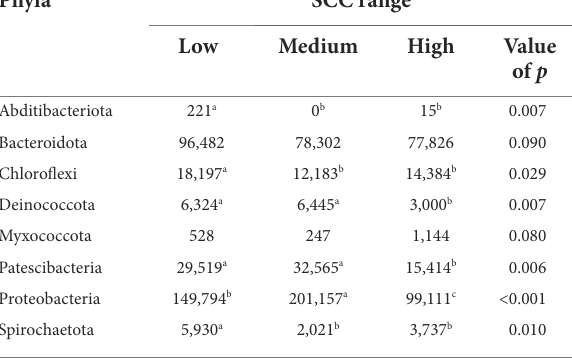
TABLE 5 Bacterial phyla relative abundance (ppm) in the milk samples of Holstein dairy cattle associated with different somatic cell count (SCC) ranges at time of collection: low, medium, and